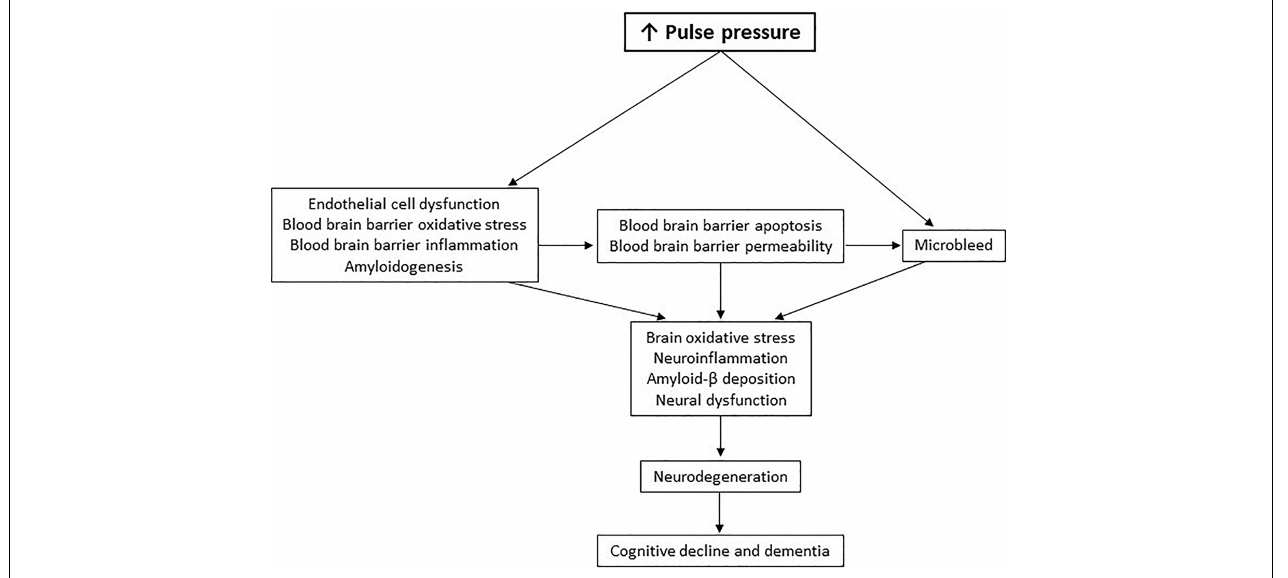
FIGURE 2 | The pulse-pressure-induced cognitive decline